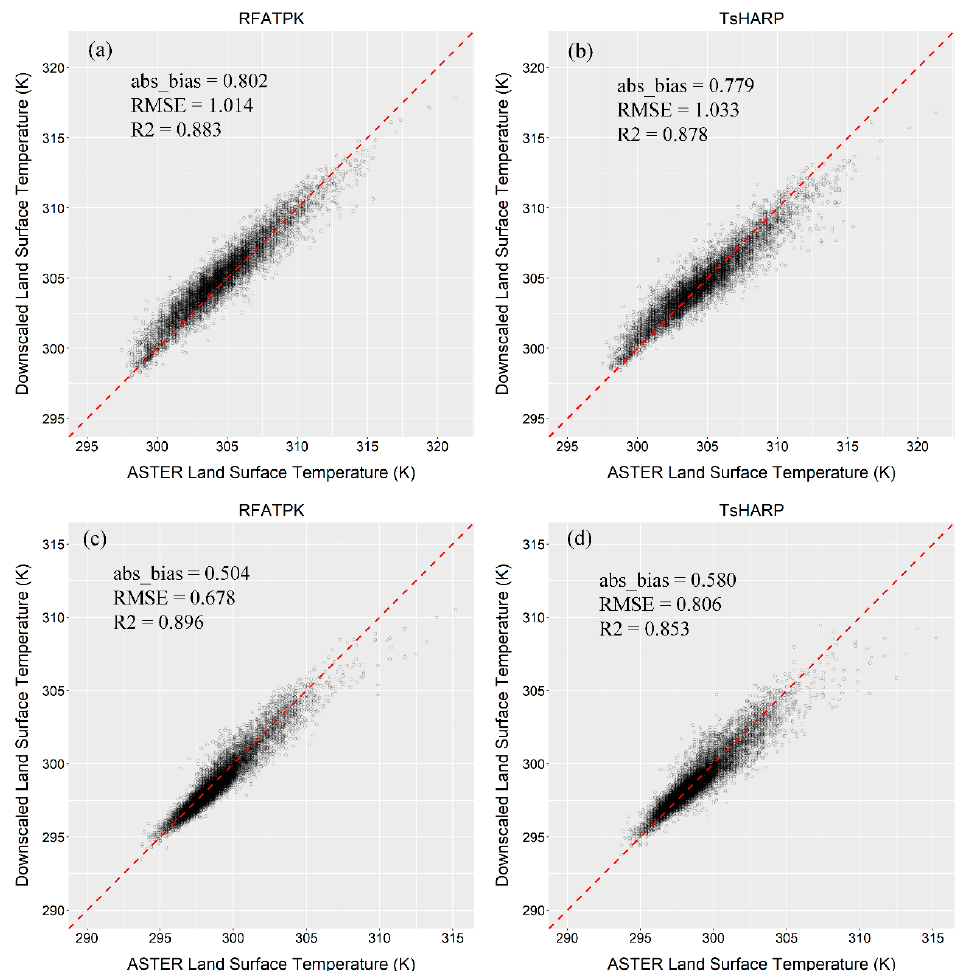
Figure 3 . Scatter diagrams of ASTER LSTs versus downscaled LSTs for two typical regions. ( a ) RFATPK-based downscaled LST for region A; ( b ) Normalized difference vegetation index based thermal sharpening method (TsHARP) based downscaled LST for region A; ( c ) RFATPK-based downscaled LST for region B; and ( d ) TsHARP-based downscaled LST for region B.